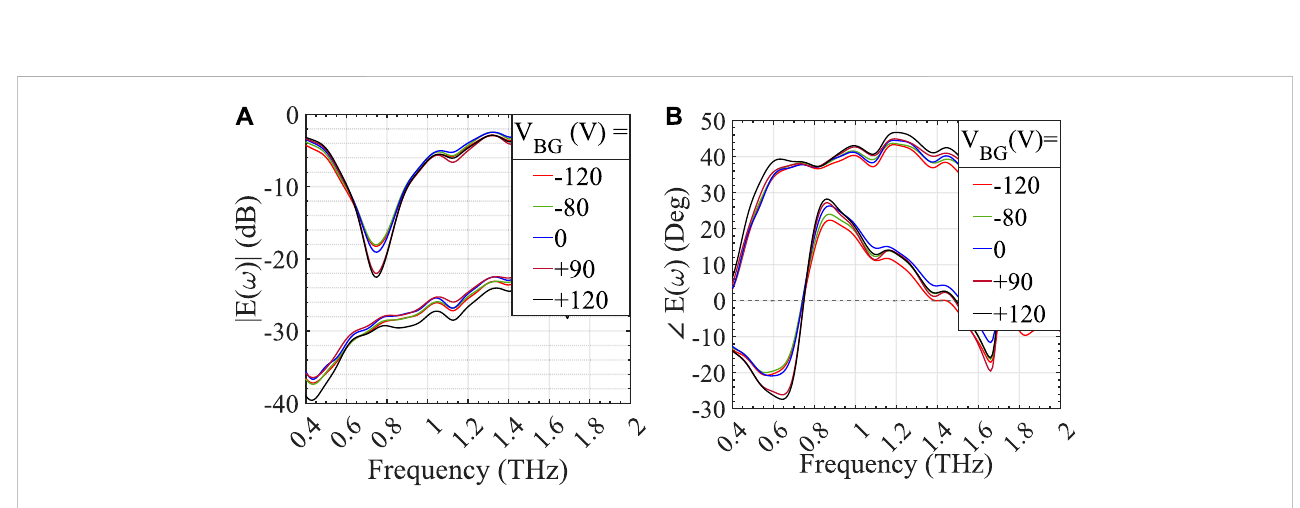
FIGURE 5 Normalized spectral amplitudes (A) and relative phases (B) considering only the fi rst temporal pulse at different V BG voltages when θ SR = 30 o and − 30 o and +60 o . Φ AZ =